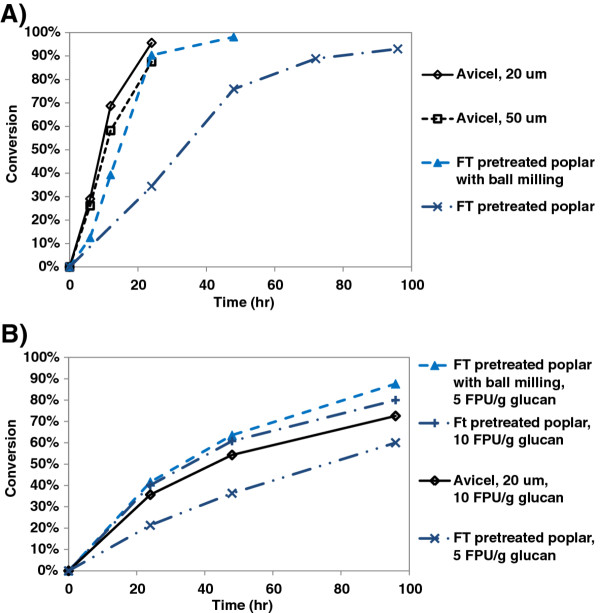
Glucan conversion on various substrates for A) C.thermocellumand B) simultaneous saccharification and fermentation (SSF).